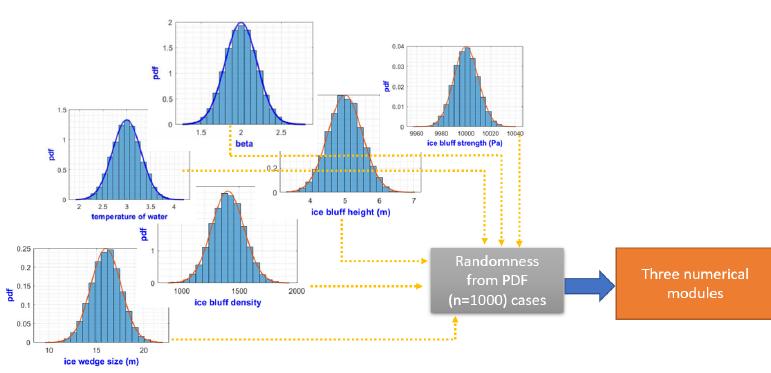
Figure 8. Generation of cases for the Monte Carlo